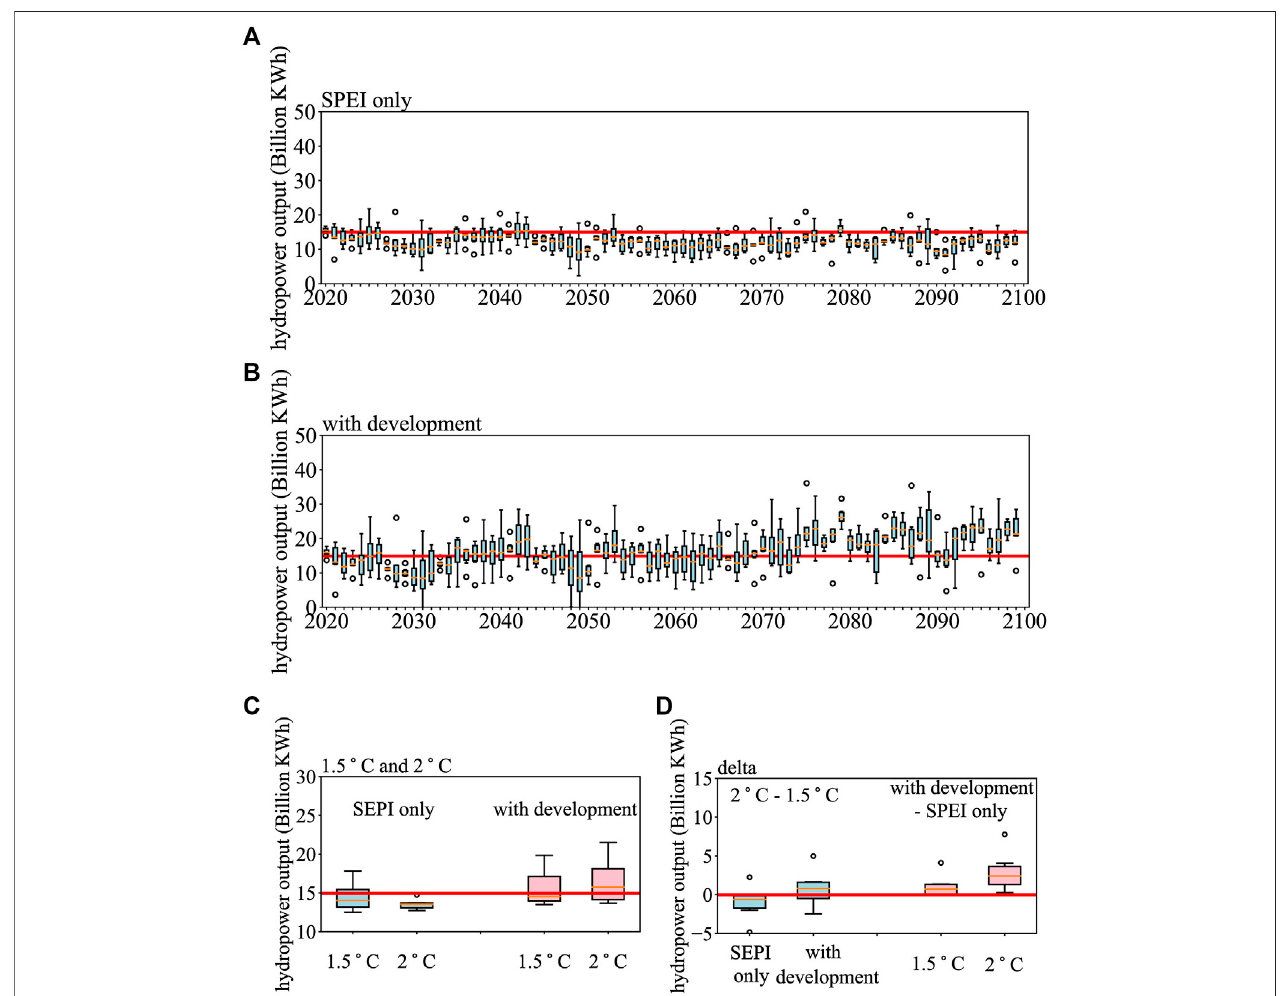
FIGURE 10 | Projections of hydropower capacity in Zhejiang Province during 2020 – 2100 under RCP4.5 when (A) considering only the meteorological condition and (B) considering the joint effects of the meteorological condition and the development of the hydropower station. (C) Projections of hydropower capacity in Zhejiang Province under the 1.5 and 2 ° C warming target when only the meteorological conditions are considered (blue) and considering the joint effects of the meteorological condition and the development of the hydropower station (pink). (D) Differences between the 2 and 1.5 ° C warming target (blue) and the effects of considering the developmentofhydropowerstations(pink).Theredlinesindicatethehistoricalmean(1999 – 2018)ofhydropowercapacityinZhejiangProvincein (A – C) andindicatethe zero lines in (D) . Open circles indicate abnormal data, color rectangles denote the spread of the 25th and the 75th quartiles, and the short orange line represents the median